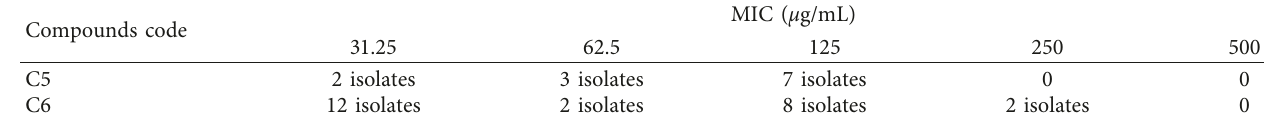
Table 9: MIC values of the new hydantoin compounds, C5 and C6, against the 12 virulent S. aureus isolates. Compounds code